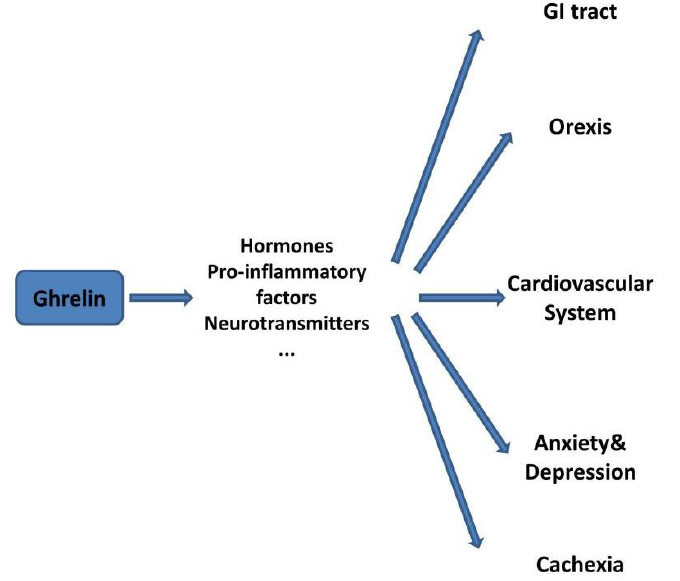
Figure 4. Ghrelin’s multifunctional role in different systems regulating homeostasis. Ghrelin is involved in the regulation of metabolic homeostasis, the digestive system, the cardiovascular system, emotional feedback, cachexia, and other aspects, and it is necessary to take all of these aspects into consideration. It is worth exploring whether these factors’ involvement in the downstream pathway regulated by ghrelin can link the various systems.